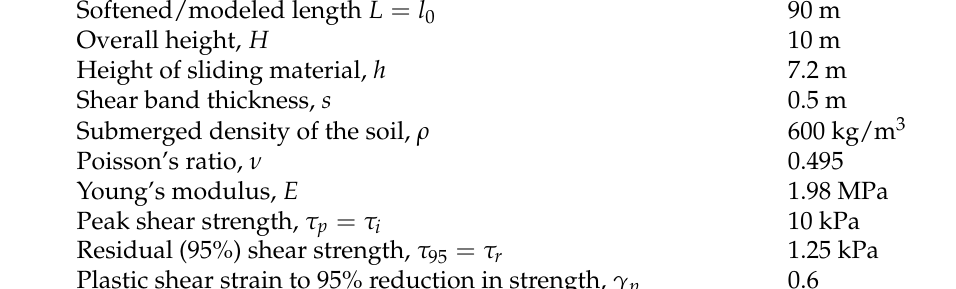
Table 2. Parameters for the shear degradation analysis.